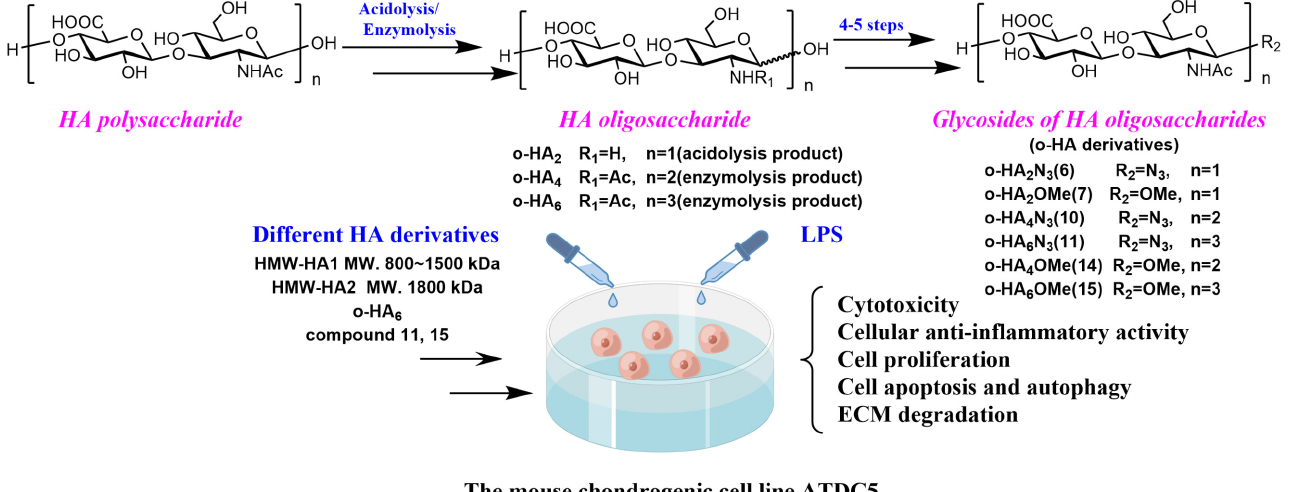
Figure 1. Synthesis of glycosides of HA oligosaccharides and evaluation of their biological activity in ATDC5 cells.